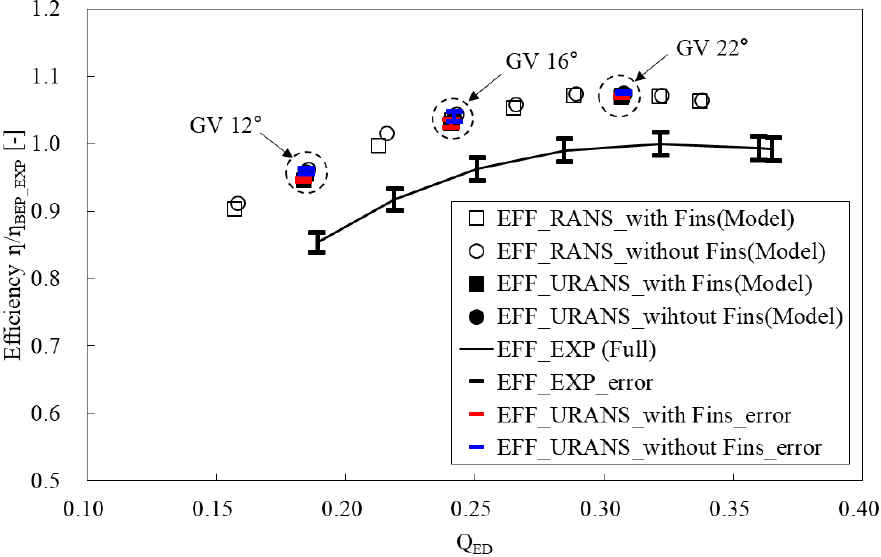
Figure 5. Comparison of the conversed numerical results and the experimental results of a full-scale Francis turbine.